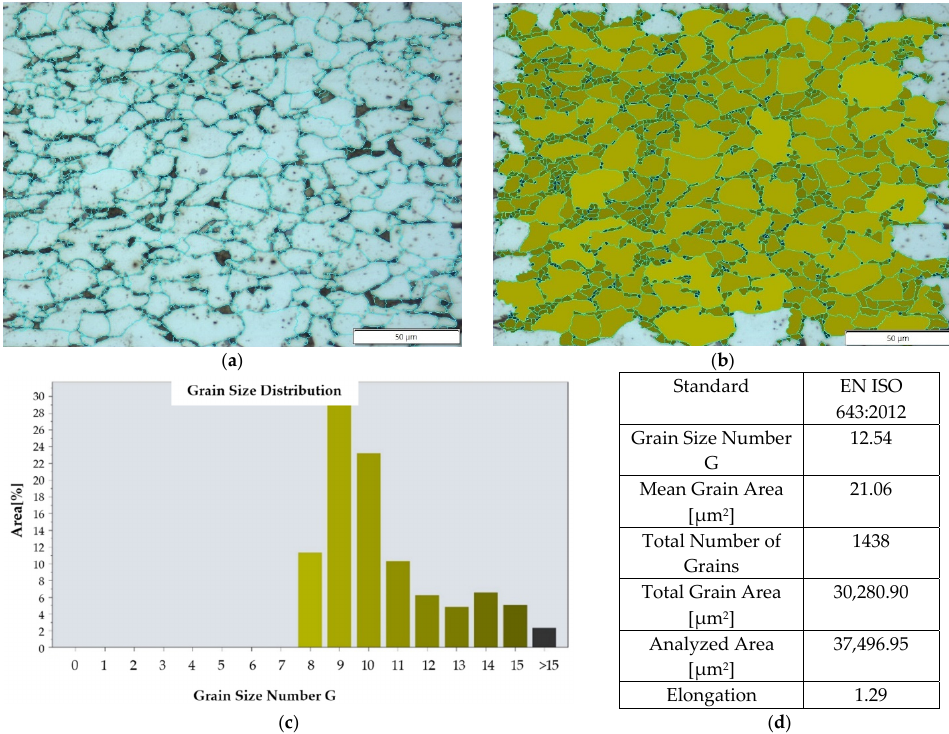
Figure 1. Grain size measurement (made on the optical microscope) of the base material, a sample taken parallel to the rod axis: ( a ) grain outline, ( b ) grain size map, ( c ) grain size histogram, ( d ) result for the examined area.